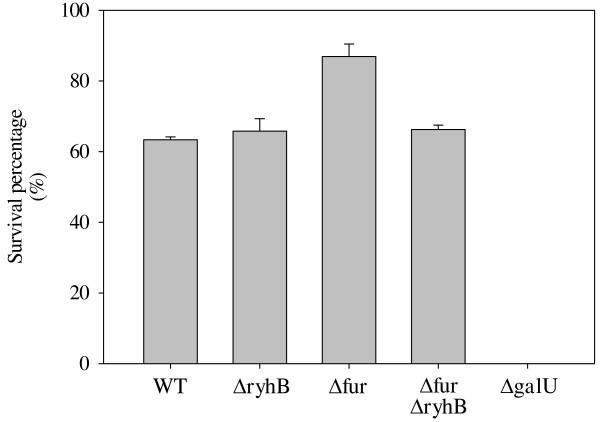
Effect of Fur and RyhB on susceptibility to normal human serum. Survival percentage of WT, ΔryhB, Δfur, ΔfurΔryhB, and ΔgalU (negative control) strains on treatment with 75% healthy human serum was determined, respectively. The results shown are an average of triplicate samples. Error bars indicate standard deviations.